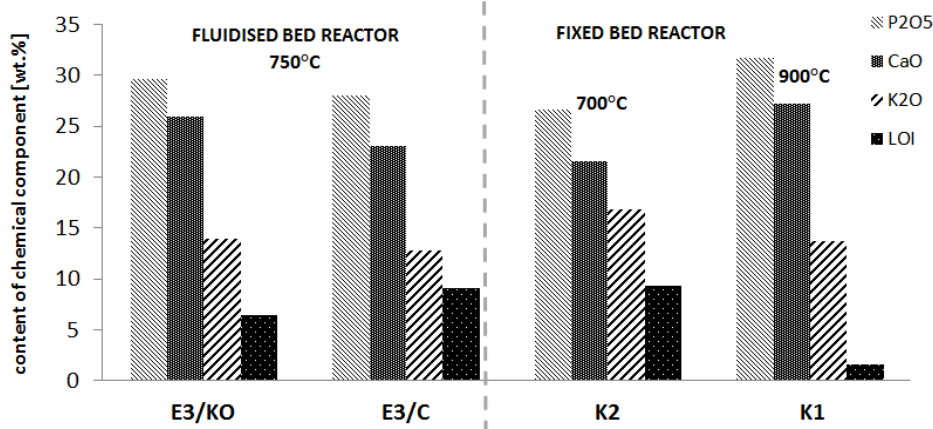
Figure 9. Comparison of the composition of ash obtained from the combustion of poultry manure in a fluidised bed reactor and a fixed bed reactor (E3/KO, E3/C—own work; K2, K1—[31]).